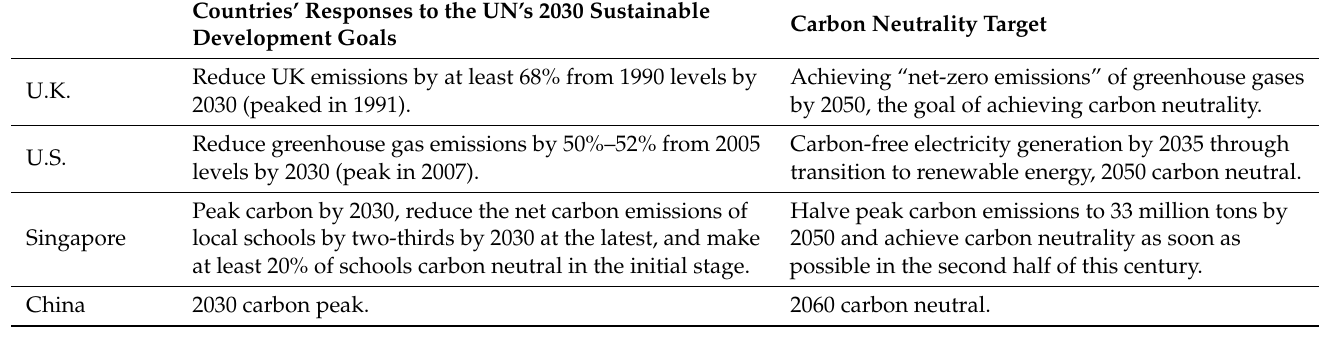
Table 1. National policies to respond to carbon neutrality.